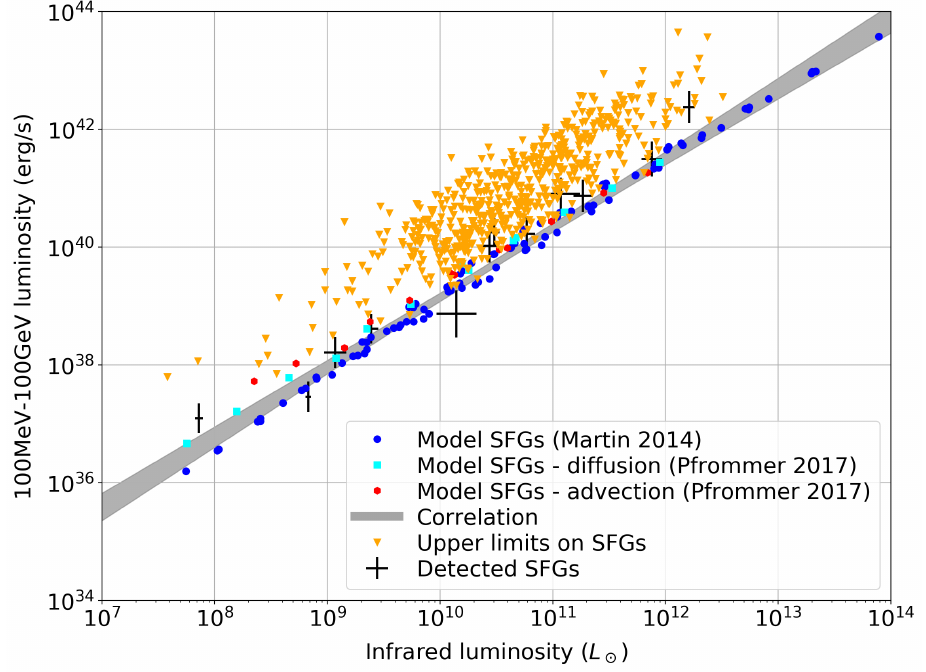
Figure 5. Gamma-ray to infrared luminosity correlation. The observed luminosities plotted as black crosses and orange triangles come from Ajello et al. [372] and were converted to the 0.1–100GeV range under the assumption that the emission spectrum is a power law spectrum with photon index 2.2 (the average value measured by the authors). The correlation band plotted in gray is the one corresponding to the so-called combined fit. Overlaid are predicted luminosities: from [378], as blue dots, for a GALPROP-like model of galaxies with different size and gas distributions and under the assumption of a Milky-Way-like CR diffusion scheme; from Pfrommer et al. [393], as red hexagons and cyan squares, for a series of two-fluid magneto-hydrodynamical galaxy formation simulations for a variety of dark matter halos and under two different assumptions for CR transport: pure advection, and advection plus anisotropic diffusion (see